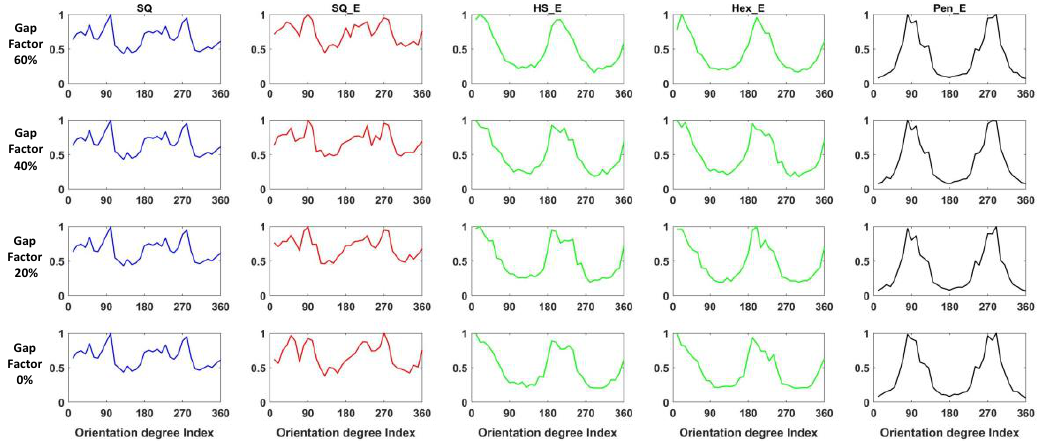
Figure 14. The results of ANCHORs from different types of images with different configurations of gap factor. Table 1. The average MSE of orientation of four image types with different configurations of gap factor referred to the 0% gap factor.